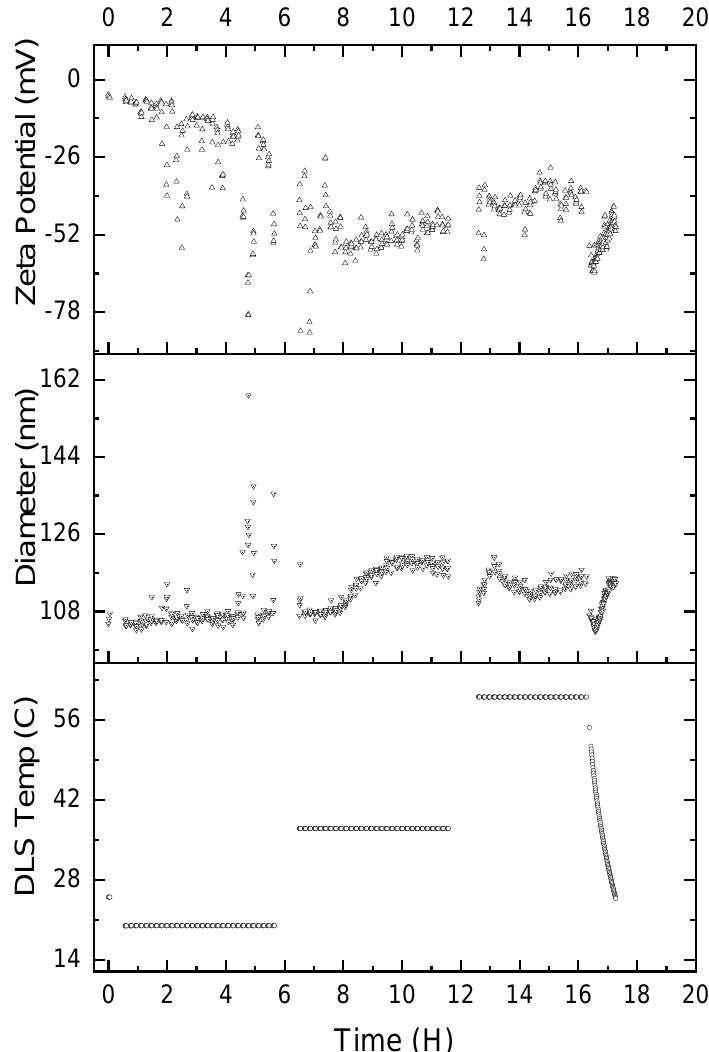
Figure 8. Accelerated exposure of α -glucan nanoparticles for 5 ½ h intervals at 25, 37, and 60 °C, respectively; temperature conditions were gradually returned to 25 °C after 16 h.